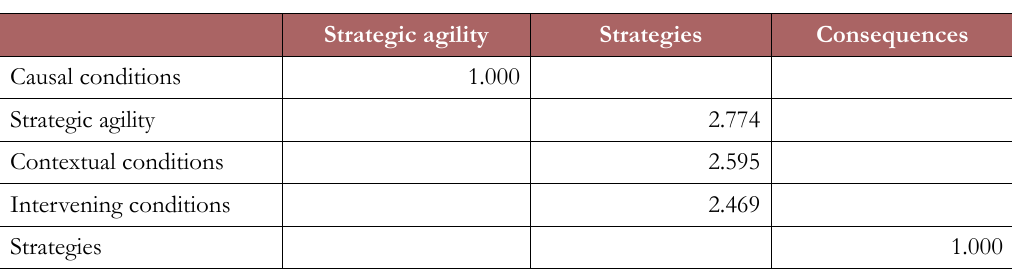
Table 14. Collinearity Statistics (VIF)